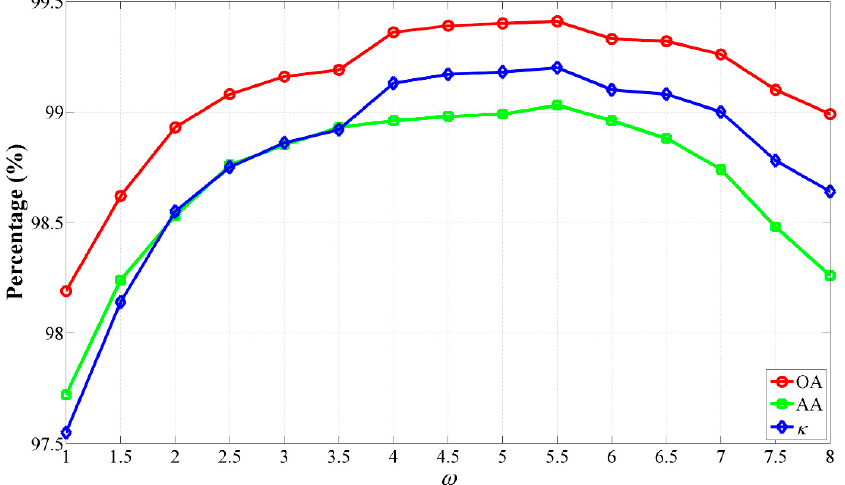
Figure 11. Analysis of the impact of ω on classification accuracies using the CS-GC + JBF method for the University of Pavia data set.